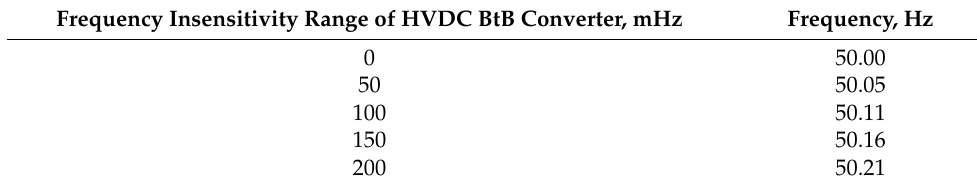
Table 6. Frequency increase in the isolated power